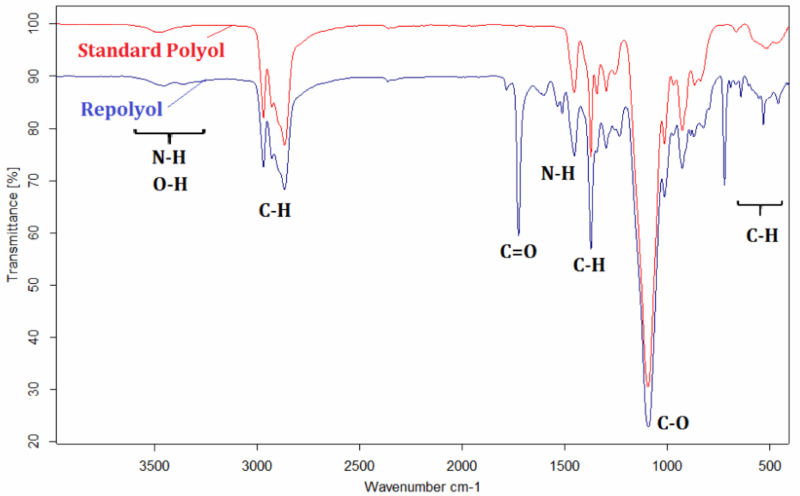
Figure 1. FTIR spectra of the recycled polyol (blue line, lower spectrum) and the reference polyol (red line, upper